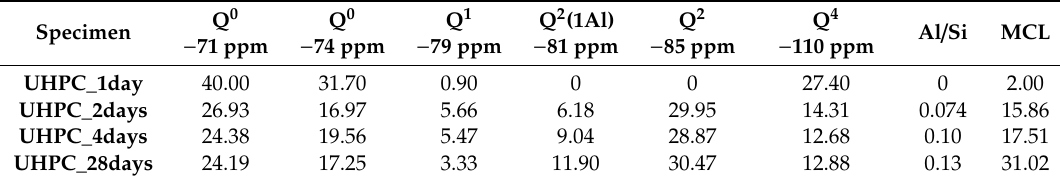
Table 2. Deconvolution results for 29 Si MAS NMR spectra,